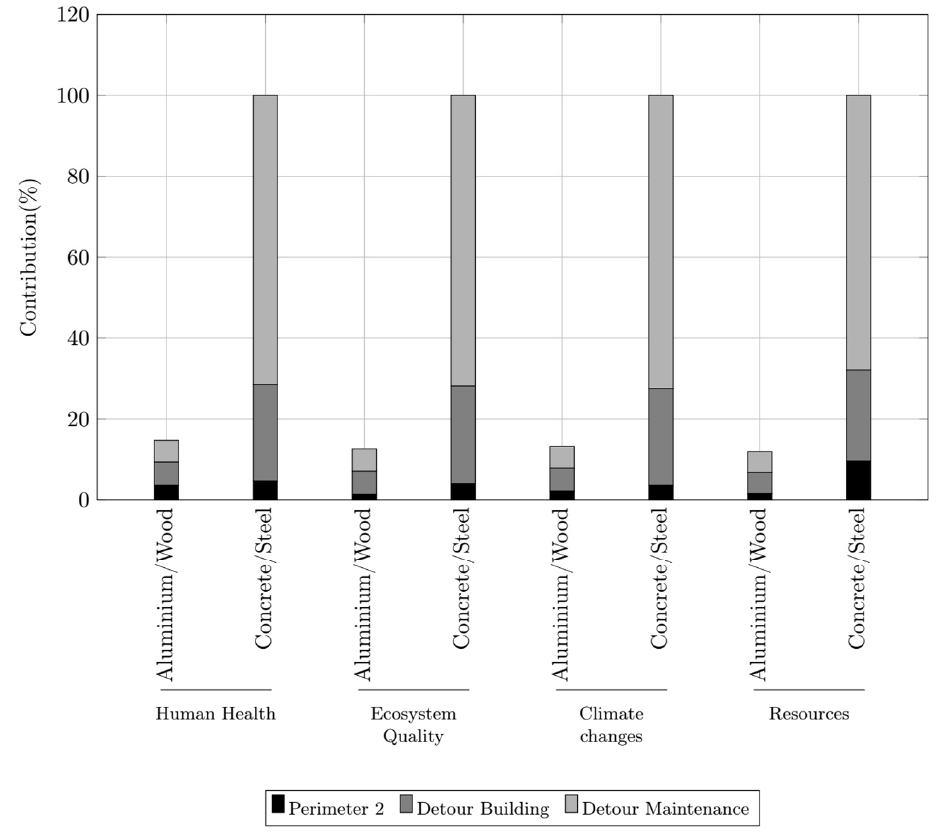
Figure 10. Comparison of environmental impacts; aluminum/steel deck versus aluminum/wood deck; perimeter 2.